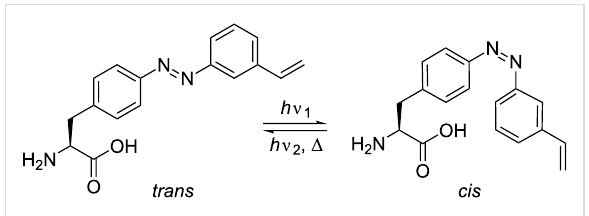
Scheme 1: Photoisomerization of the photoswitchable click amino acid 2-amino-3-(4-((3-vinylphenyl)diazenyl)phenyl)propanoic acid.